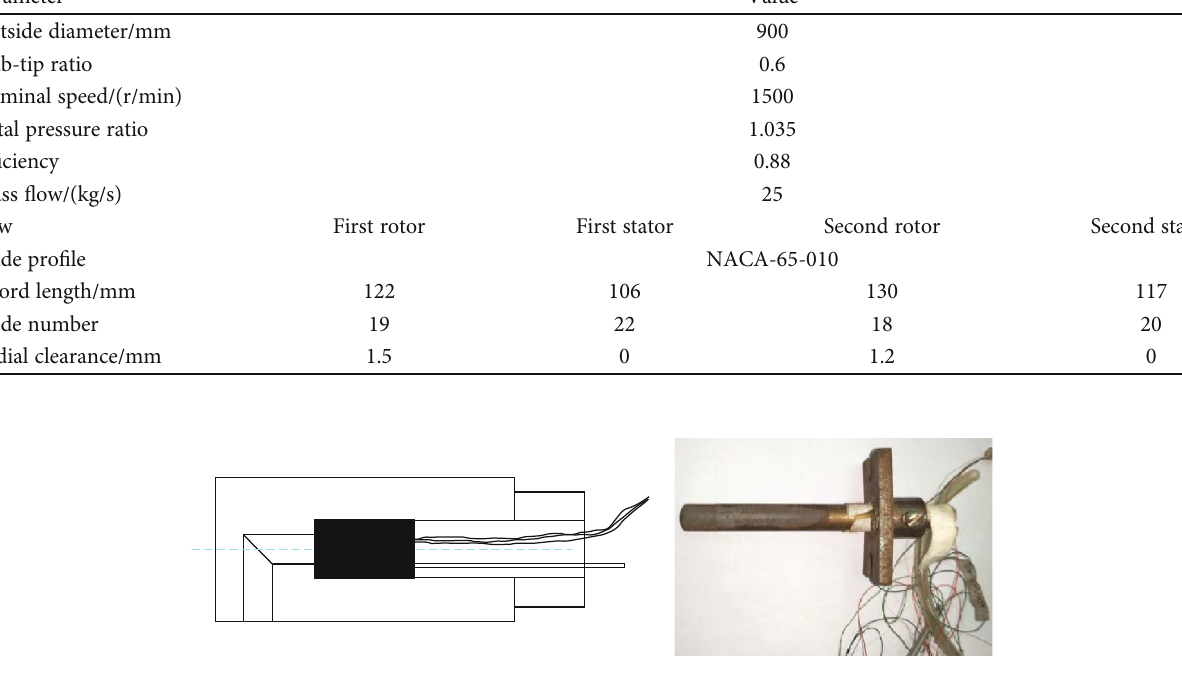
Figure 2: Structure diagram of the dynamic total pressure probe.